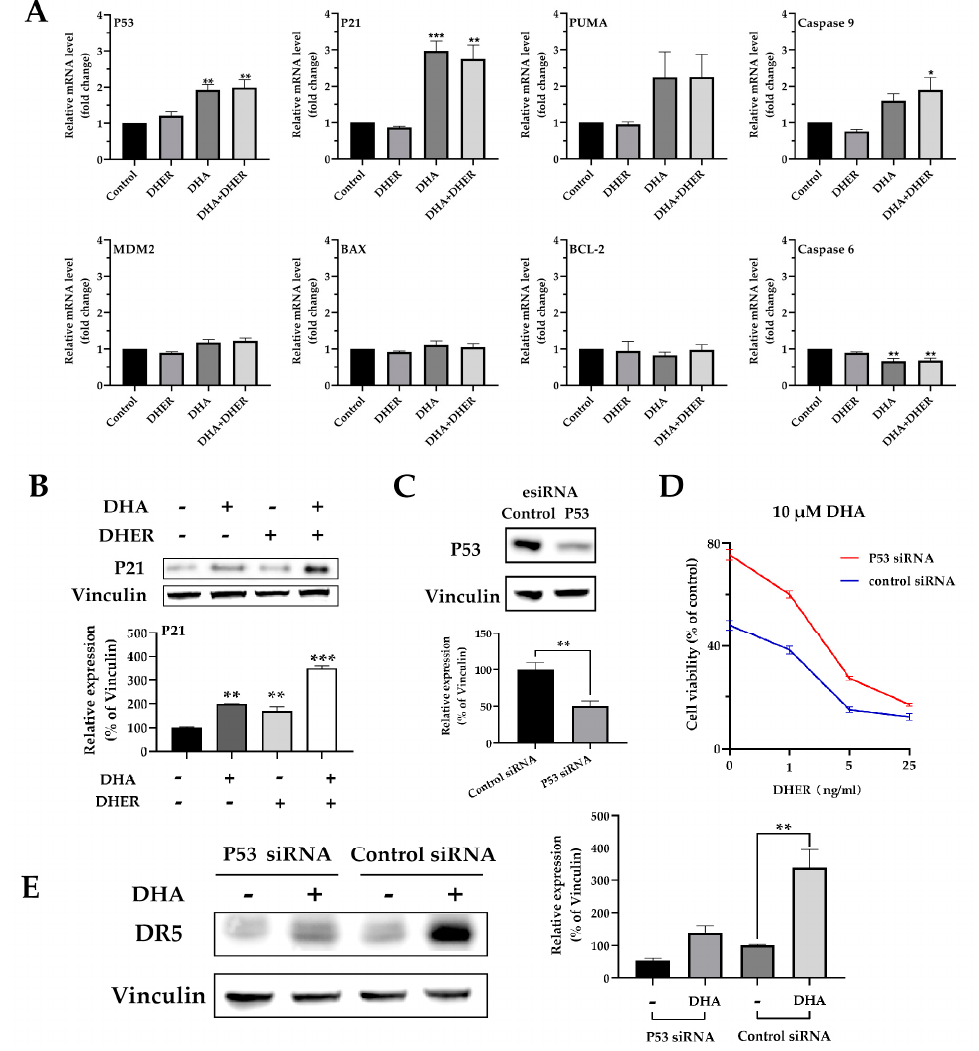
Figure 7. DHA influences the p53 pathway in HCT116. ( A ) Relative mRNA levels of P53, P21,